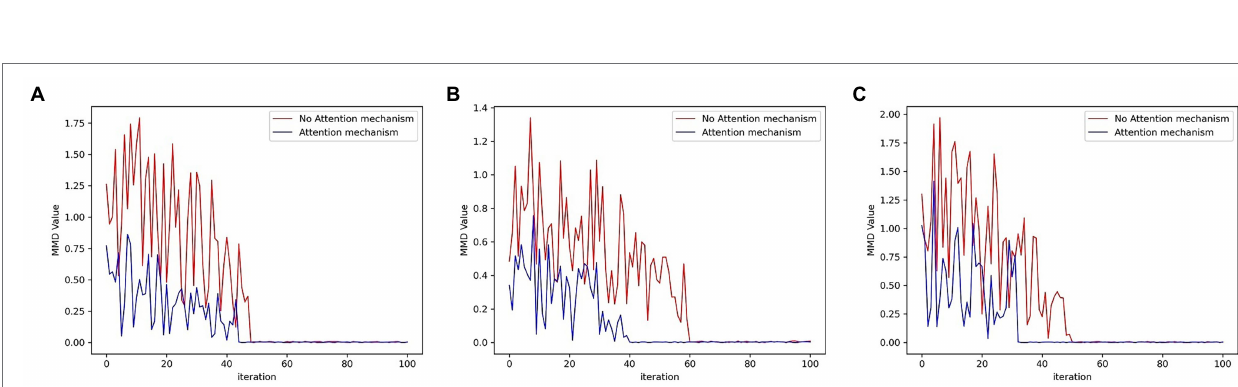
FIGURE 8 | Comparison of reconstruction effects on the HomeC data set (A) Real sample; (B) No attention mechanism; (C) Attention mechanism.